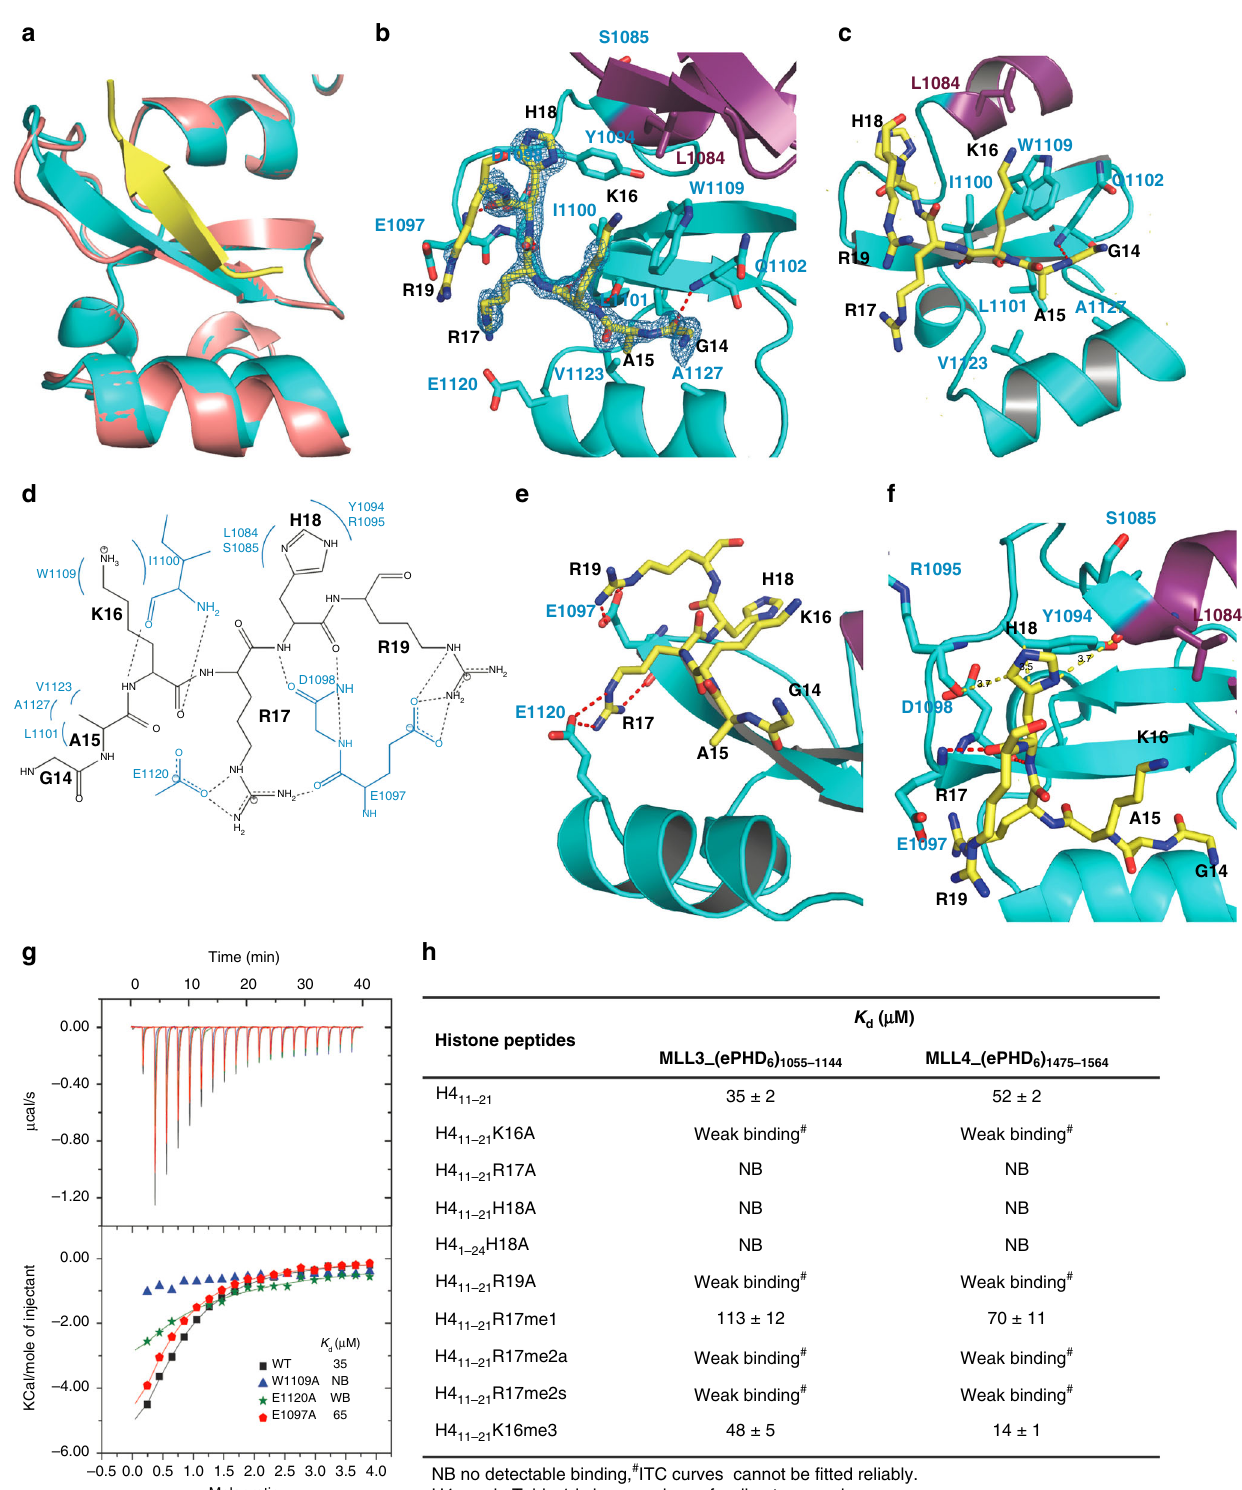
Fig. 2 The ePHD 6 domain of MLL3 speci fi cally binds to the H4H18-containing motif of histone H4. a Superimposition of the structures of the H4 peptide- bound and peptide-free ePHD 6 domain of MLL3. b Cartoon representation of the PHD 6 and preceding zinc fi nger colored in cyan and purple, respectively. The histone H4 peptide is shown with a Fo – Fc omit map contoured at 2.5 σ . c , e , f Detailed interactions between the ePHD 6 domain of MLL3 and residues A15/ K16, R17/R19, and H18 of histone H4 peptide, respectively. The histone H4 peptide is shown in sticks and colored in yellow. Interacting residues are shown in stick mode and red/yellow dashed lines represent intra-molecular hydrogen bonds and atom distances, respectively. d Schematic of the detailed interactions between the ePHD 6 domain of MLL3 and the H4H18 histone H4 peptide. The histone H4 interacting residues of MLL3 are colored in blue. Dashed lines represent hydrogen bonds. g ITC curves for the titration of wild type or different mutants of ePHD 6 domain of MLL3 to the histone H4 peptide H4 11 – 21 . NB no detectable binding, WB, weak binding. h Binding af fi nities of different histone peptides to ePHD 6 domain of MLL3 and MLL4 measured by